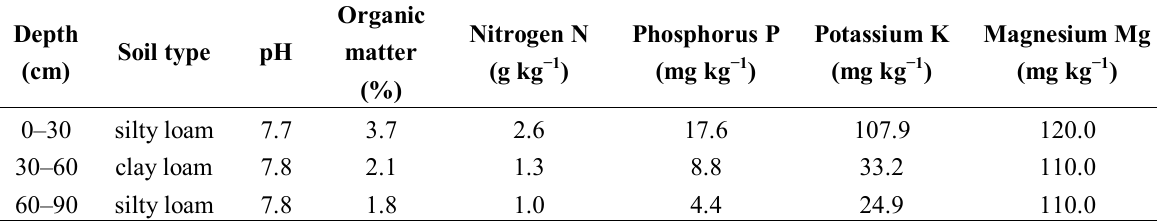
Table 1. Research plot soil types and nutrient